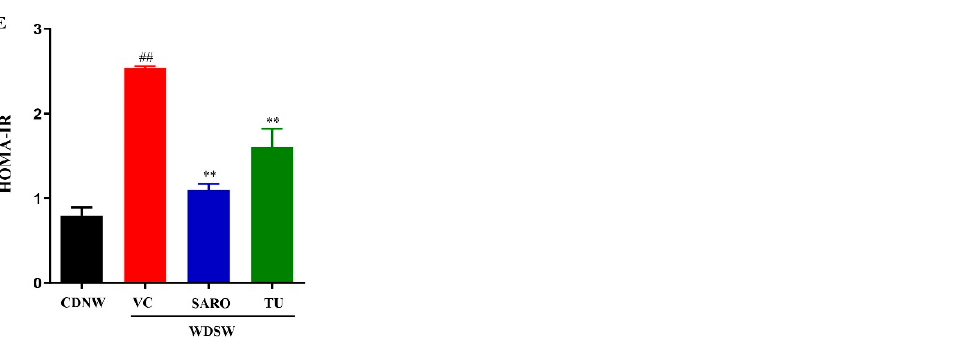
Figure 1. Tecomella undulata ( TU ) reduced body weight and improved insulin resistance in high fat diet-induced obese mice. Mice were treated with CDNW or WDSW for 12 weeks and, following that, WDSW mice were divided into 3 groups and treated with (i) vehicle control (VC) (ii) saroglitazar (SARO) (iii) Tecomella undulata (TU) via oral gavage for additional 12 weeks. At the completion of the treatment, body weight ( A ), liver weight ( B ), fasting glucose ( C ), and fasting insulin ( D ) were measured. HOMA-IR ( E ) was calculated using the formula: (fasting insulin (milliunits/liter) × fasting glucose (mmol/liter))/22.5. Data are expressed as mean with SEM for 8–10 mice per group. ## p < 0.001 compared to CDNW; ** p < 0.001 compared to WDSW, vehicle control.